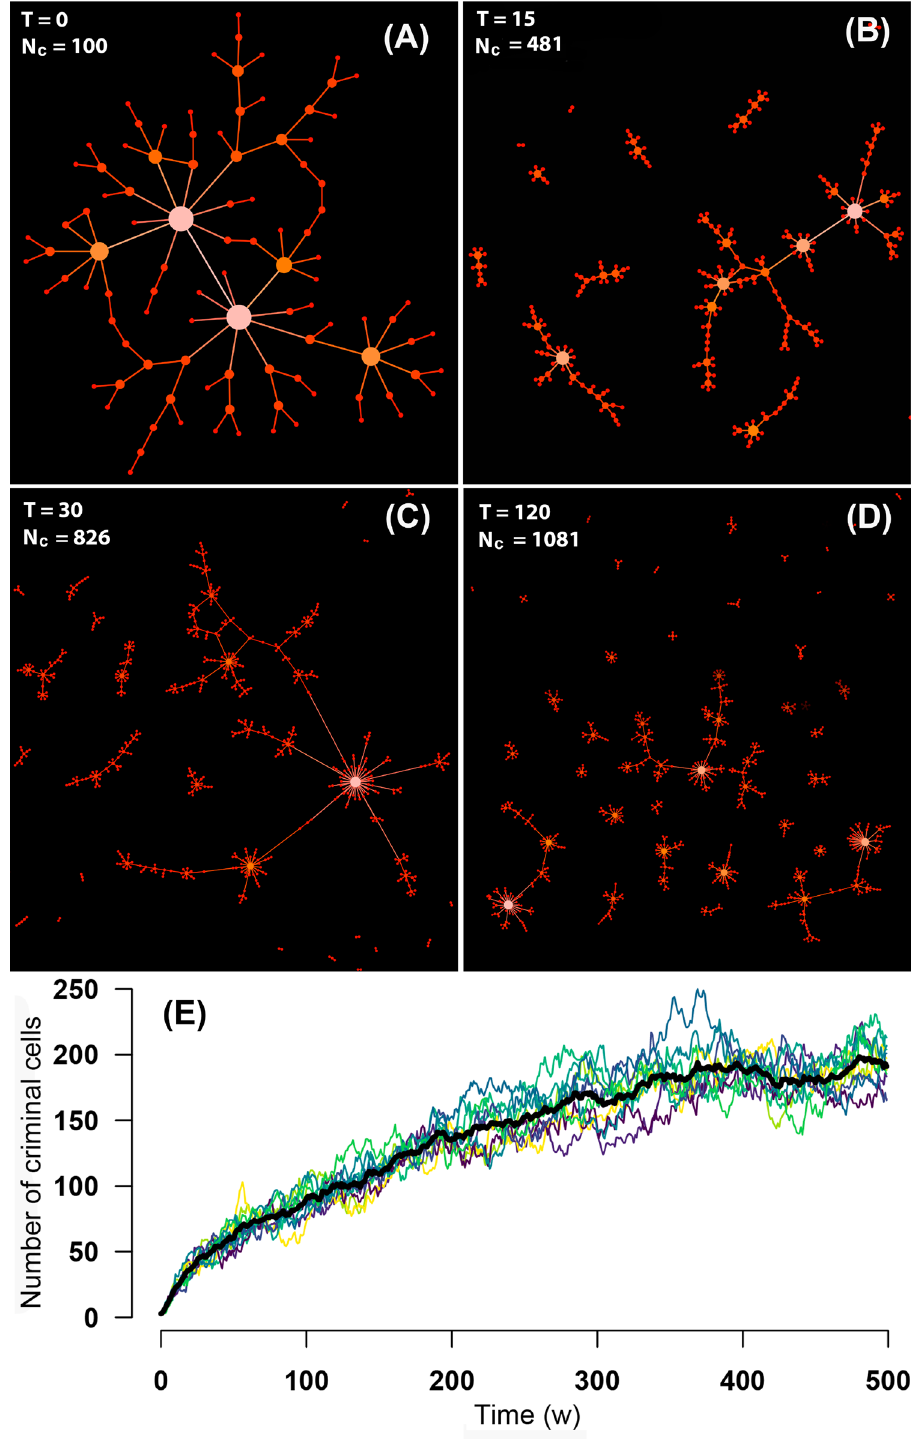
Figure 5. Evolution of the criminal network. ( A ) Initially, the criminal network is fully connected and exhibits a scale-free-like topology (although the network in this example is too small – N c = 100 – to actually define a power-law degree distribution; however, the existence of hubs is clear). ( B )–( D ) As the simulation proceeds and police officers capture criminals, the criminal network fractures into independent subnetworks ( criminal cells ). ( E ) The total number of criminals and independent cells increase despite the capturing of criminals by police officers. Panels ( A )–( D ) were computed with a small system ( N = 10, 000 , N p = 100 , and an initial number of criminals N c = 100 ) for illustrative purposes. Panel ( E ) was computed for systems with N = 10 5 individuals, N p = 10 3 police officers, and an initial population N c = 0.1 N of criminals. Different curves in color correspond to 10 distinct realizations. The bold-black curve is the average of these